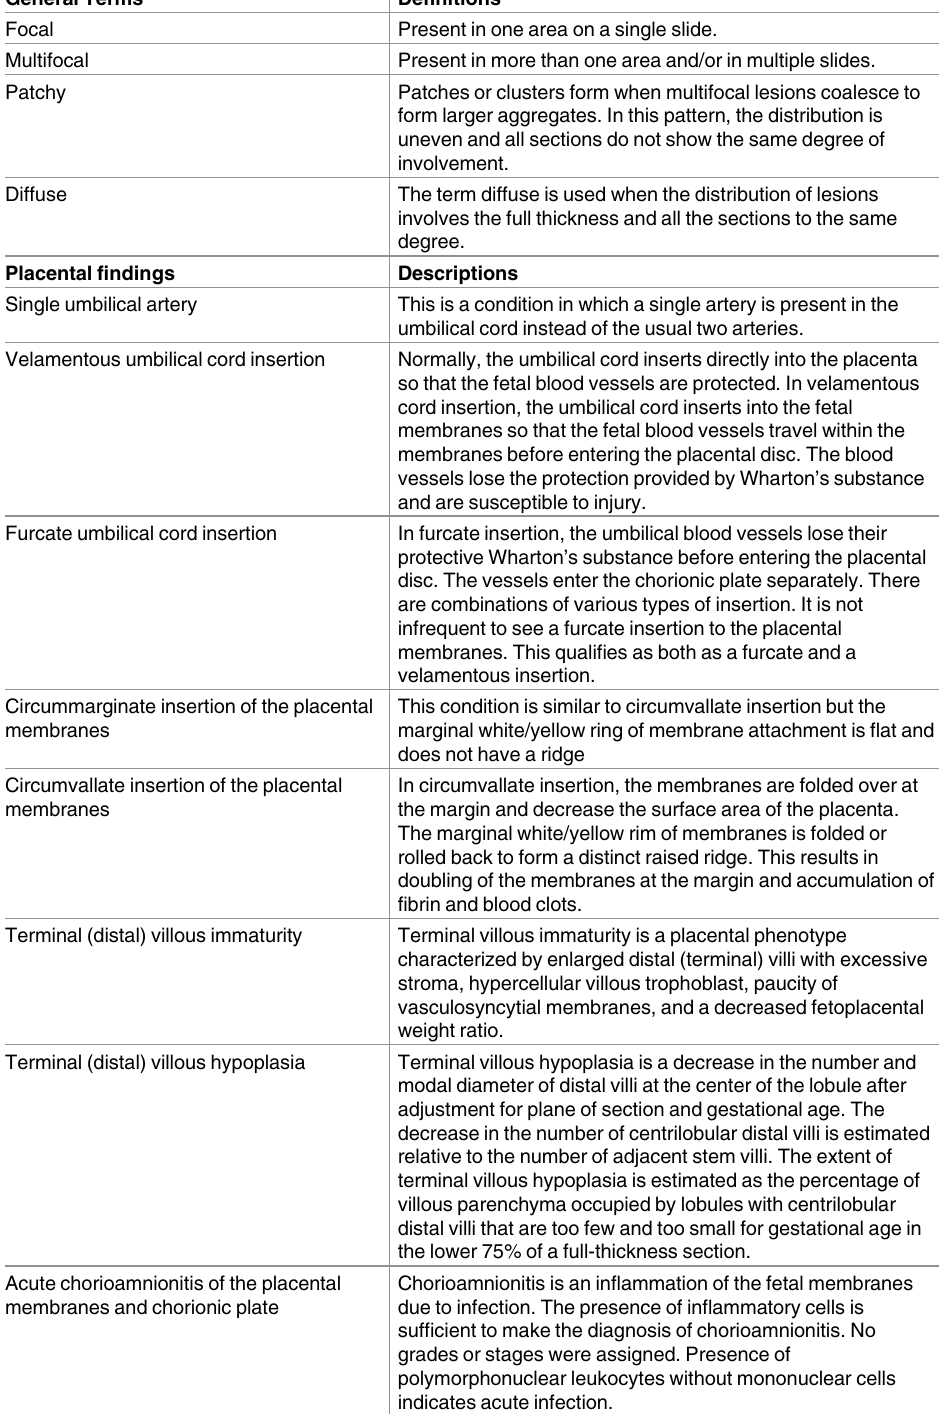
Table 1. Descriptions of the placental